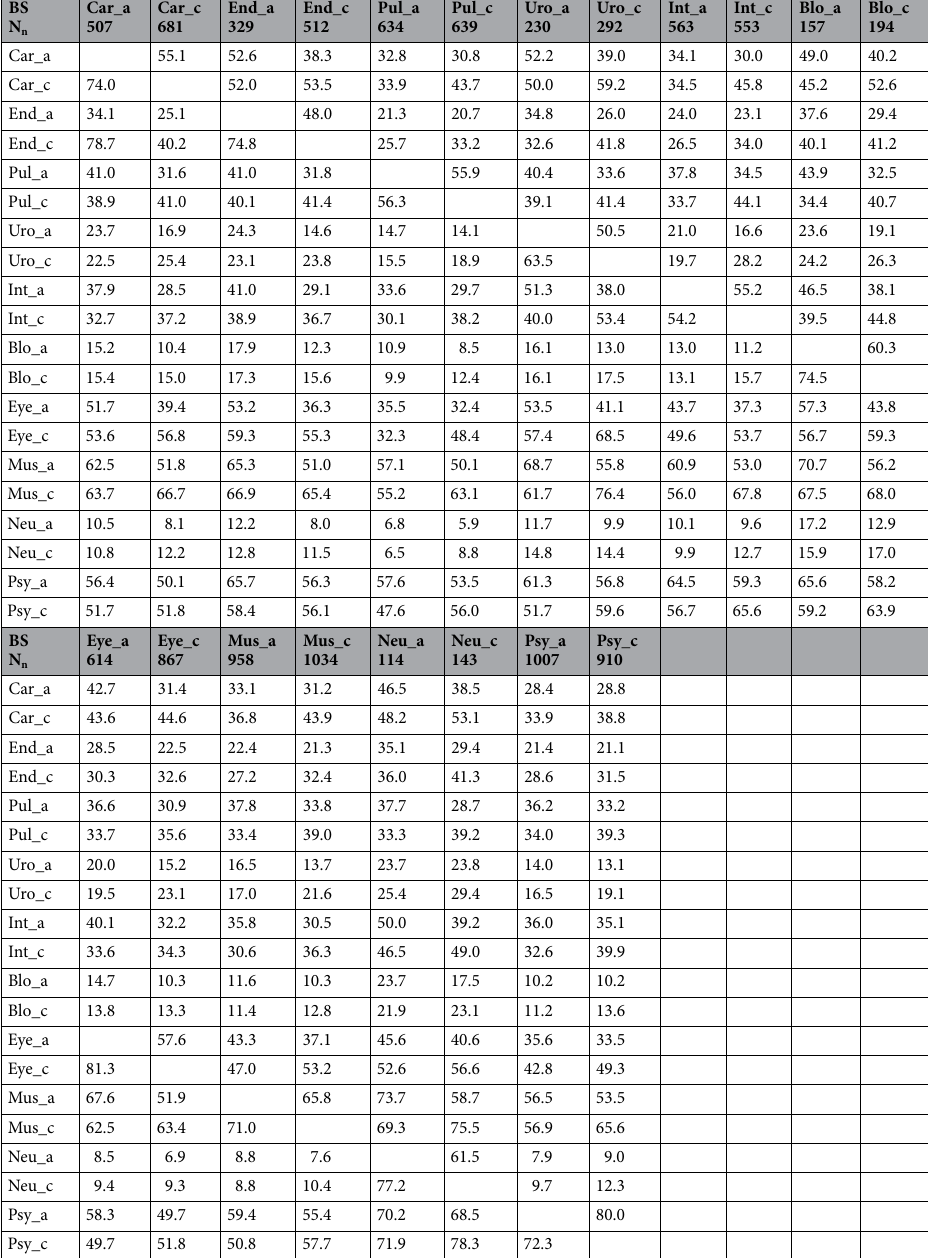
Table 1. Percentage of patients per disease (row) that have a comorbidity from another body system (column) (e.g. from 507 patients with acute cardiac problems, 74.0% also have chronic cardiac problems and 34.1% acute endocrine problems). BS, body system; a, acute; c, chronic; car, cardiac; end, endocrine; pul, pulmonary; uro, urogenital; int, gastrointestinal; blo, blood; eye, eye/ear; mus, musculoskeletal; neu, neurological; psy, mental/ psychological; N, number of patients with